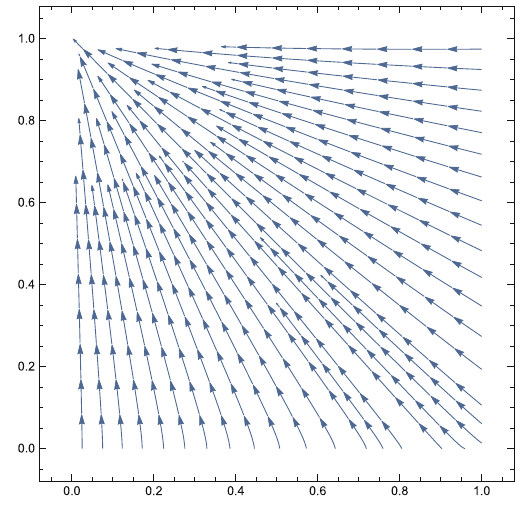
Fig. 4 Phase space diagram for the dynamical system (16), (17), (20) in the space of variables (cid:8) b ,(cid:8) (cid:2) for n < 1 and (cid:8) r = 10 − 4 . The unique attractor is the de Sitter point A